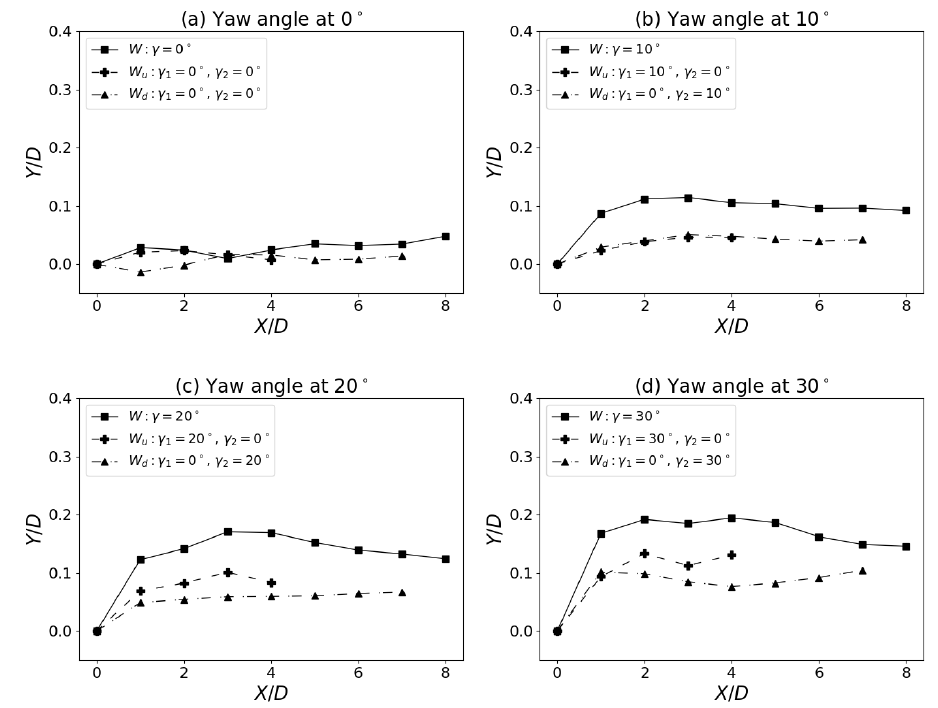
Figure 12. Wake centerlines under varying yaw angle cases. W : turbine wake centerline for Scenario 1; W u : upstream turbine wake centerline for Scenario 2; W d : downstream turbine wake centerline for Scenario 2. In all cases, the quoted distances for W and W u are downstream of the upstream turbine, while the quoted distances for W d are downstream of the downstream